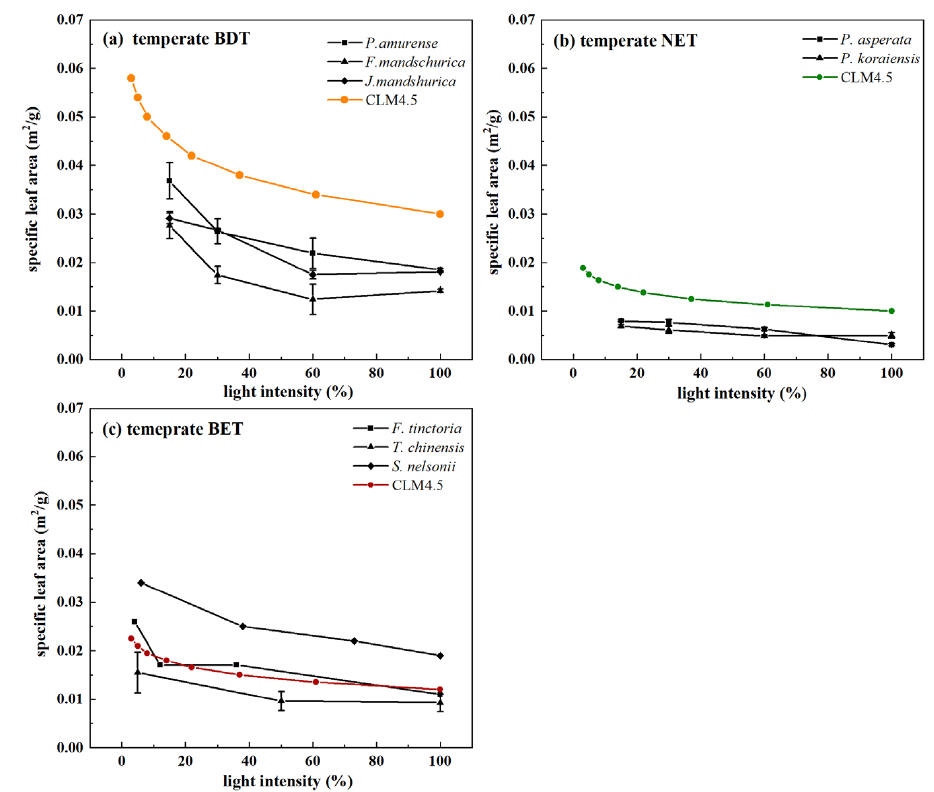
Figure 3. The responses of specific leaf area (SLA) to light gradients for temperate broadleaf deciduous tree (BDT) ( a ), temperate needleleaf evergreen tree (NET) ( b ), and temperate broadleaf evergreen tree (BET) ( c ). More details about the species can be found in Table S2 [40–43]. Table 2. The variation in specific leaf area (SLA) observations among different plant functional types (PFTs) in China. Abbreviations: NET, needleleaf evergreen tree; NDT, needleleaf deciduous tree; BET, broadleaf evergreen tree; BDT, broadleaf deciduous tree; BES, broadleaf evergreen shrub; BDS, broadleaf deciduous